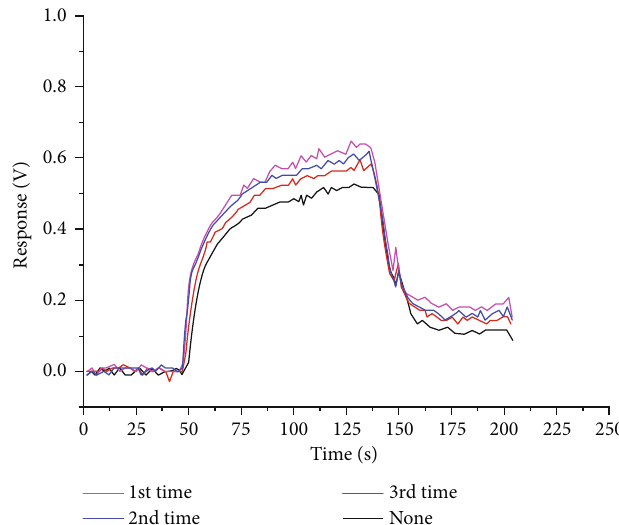
Figure 6: Voltage response contrast of the graphene oxide-coated electrode sensor with di ff erent soaked